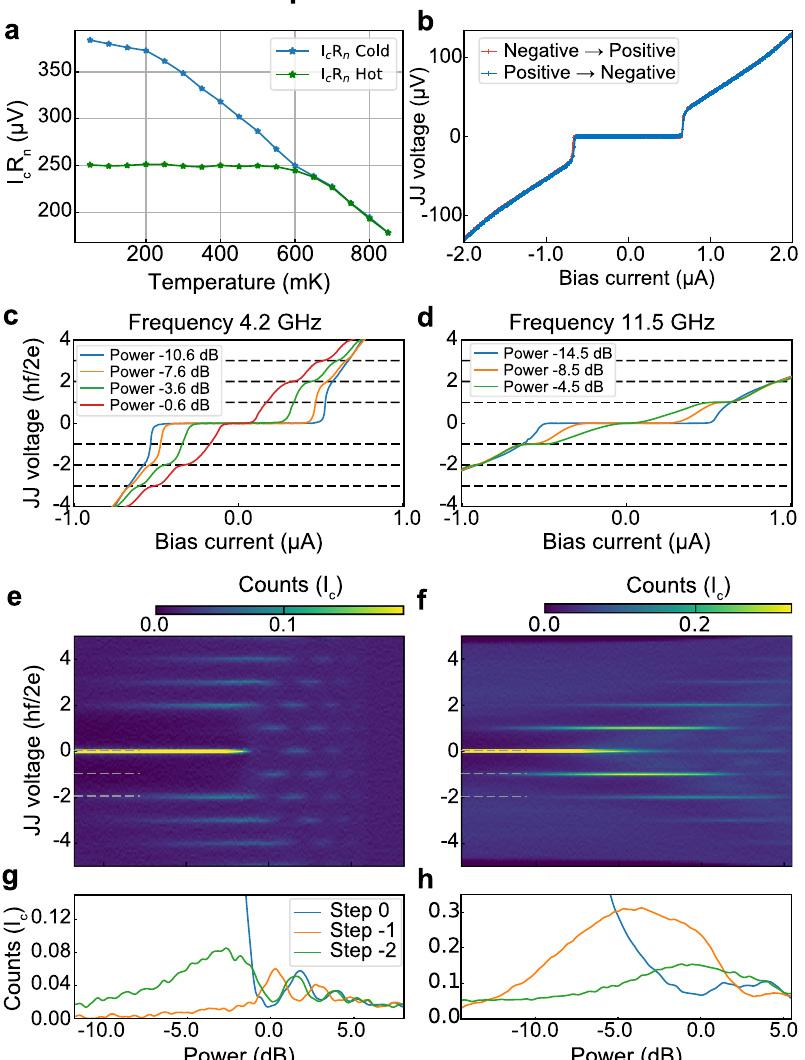
Fig. 3 Control experiment at elevated temperature. a Dependence of the I c R n product of device A2 on both the cold and hot branches as a function of temperature. b VI characteristic of device A2 at 650 mK. Voltage – current characteristic in the presence of a microwave radiation ( c , d ), histogram of the Josephson junction voltage as a function of the microwave power ( e , f ), and width of the Shapiro steps as a function of the microwave power ( g , h ) for samples A2 at 650 mK and a microwave drive of 4.2 and 11.5 GHz. The normalization follows the same conventions used in Fig.